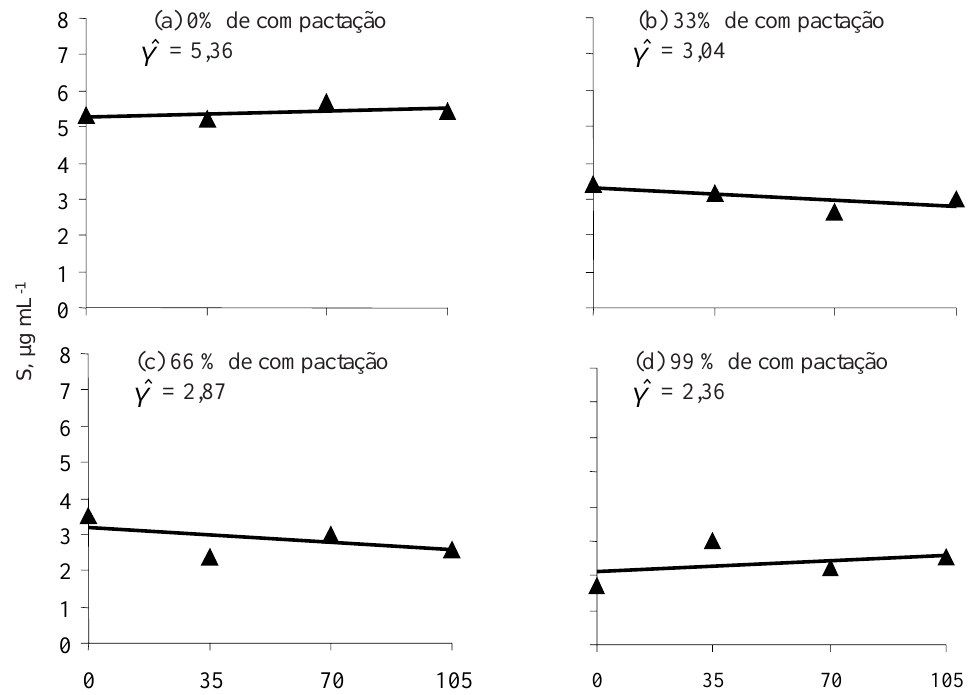
Figura 4. Teores médios de enxofre nos lixiviados, considerando as doses de carbonato, dentro de cada nível de